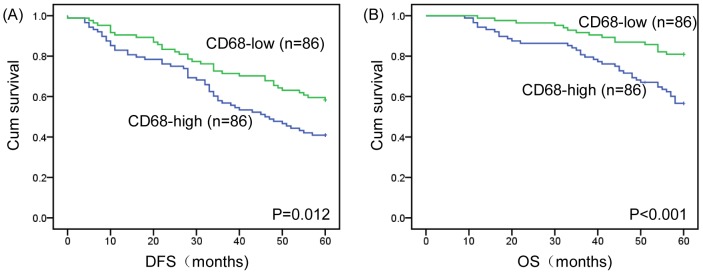
Kaplan–Meier analysis for DFS and OS based on CD68 expression in breast cancer patients.(A) Kaplan–Meier analysis for DFS based on CD68 expression in patients with breast cancer (log-rank test, P = 0.012) (B) Kaplan–Meier analysis for OS based on CD68 expression in patients with breast cancer (log-rank test, P<0.001). Green: TAM-low group; Blue: TAM-high group.